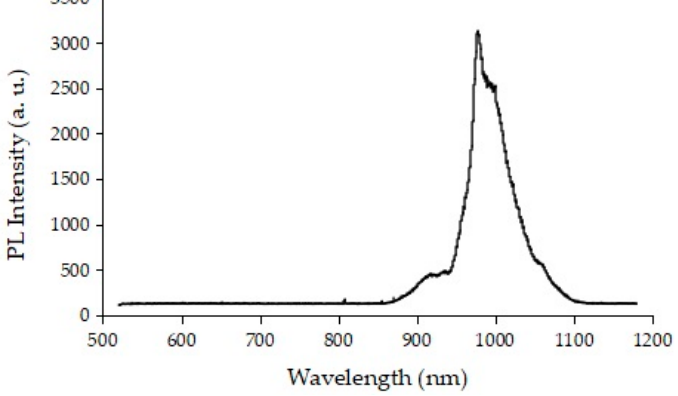
Figure 1. Photoluminescence spectrum of Yb 3+ and Nd 3+ co-doped Bi 2 O 3 -B 2 O 3 glass phosphor. Light with a wavelength of 808 nm is suitable for excitation.